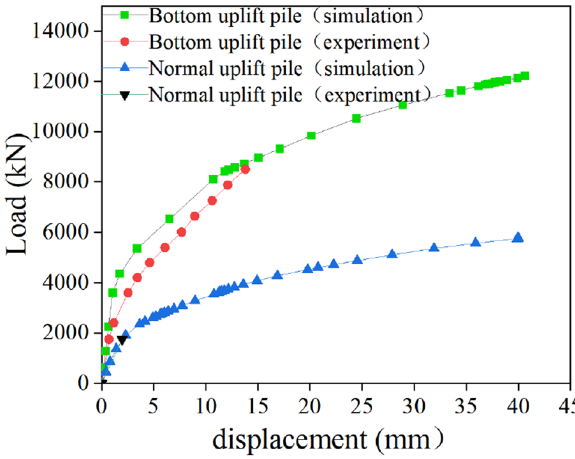
Figure 6. Q–s curves of the uplift